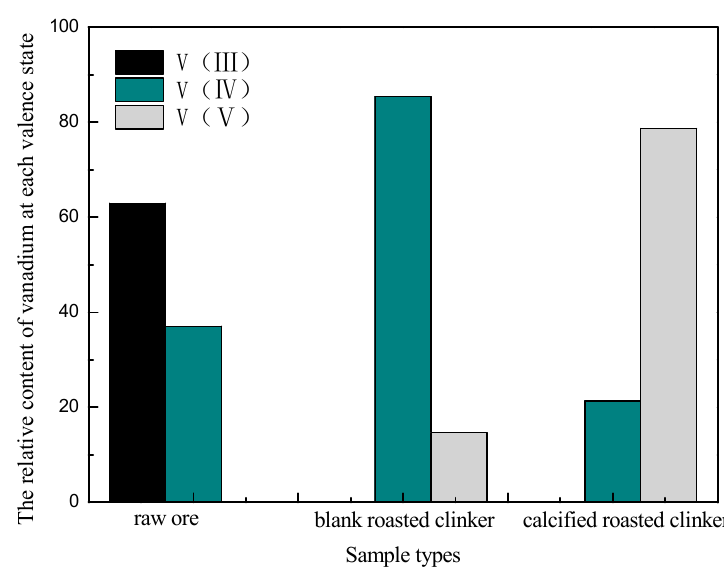
Figure 7. Vanadium valences of the raw ore, blank roasted clinker, and calcified roasted clinker.